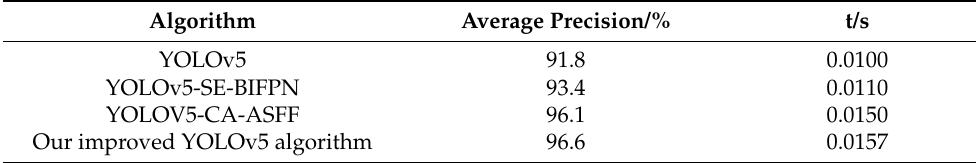
Table 6. Comparison of recognition results of four Algorithms.